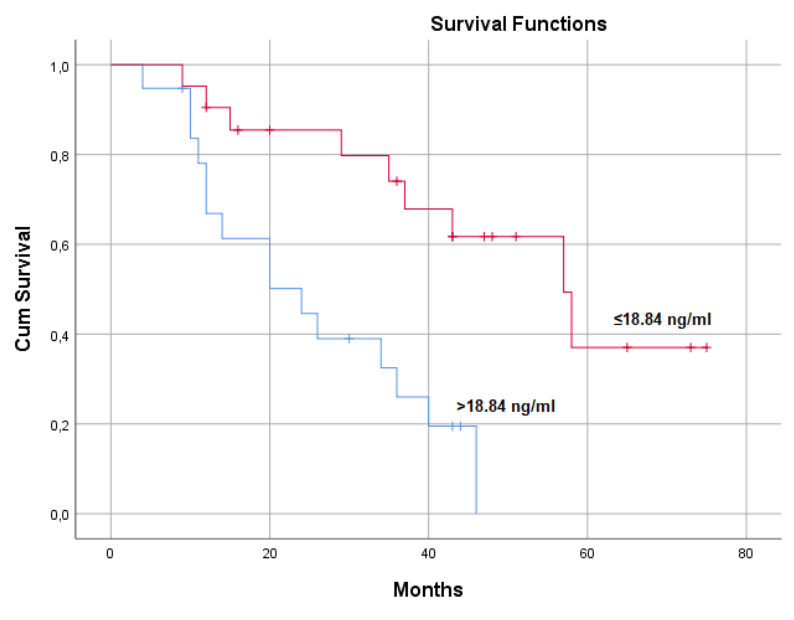
Figure 1: The survival rates with Kaplan-Meier plot for levels of suPAR.